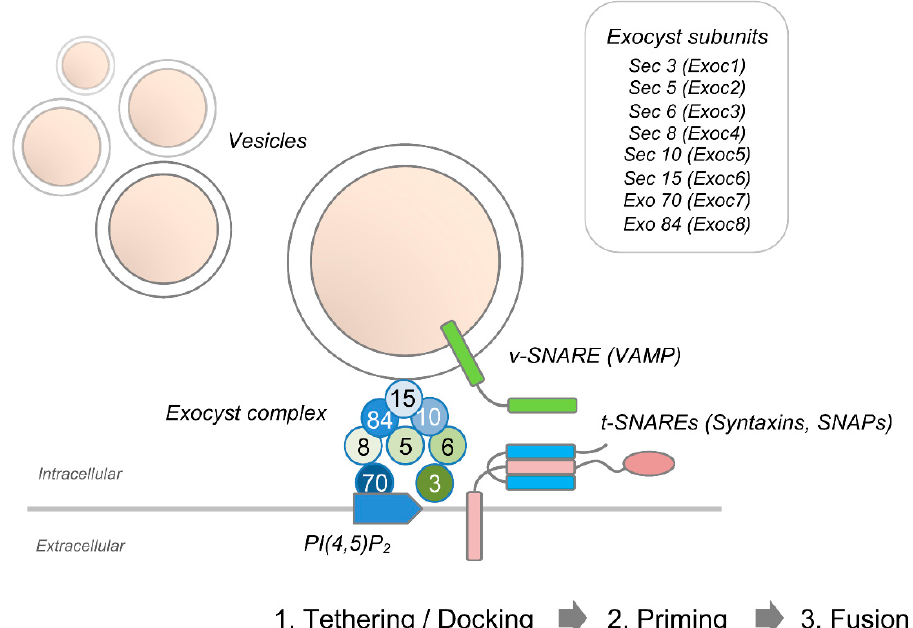
Figure 3. The exocyst protein complex. A schematic representation of the assembly of the exocyst octameric protein complex mediated fusion.